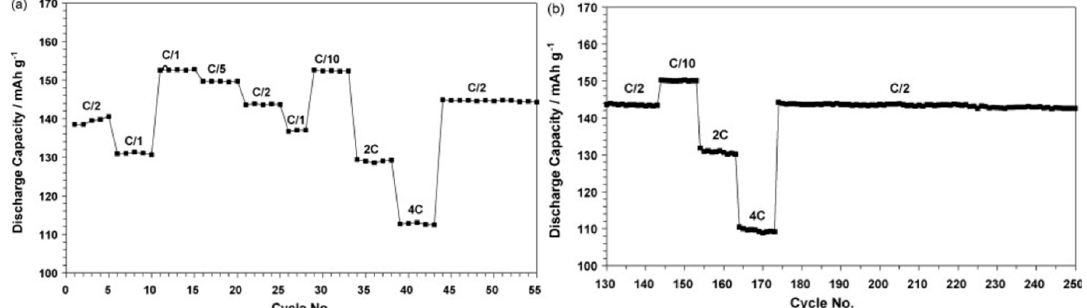
Figure 3. Cycling performance of Li | C 3 mpyrFSI–LiTFSI (0.5 mol kg − 1 ) | LiFePO 4 cell at indicated discharge rates (at 50 °C) for: ( a ) cycles 1–55 and ( b ) cycles 130–250. Charging rate is constant at C/10. Reprinted with permission from Lewandowski et al. [155].